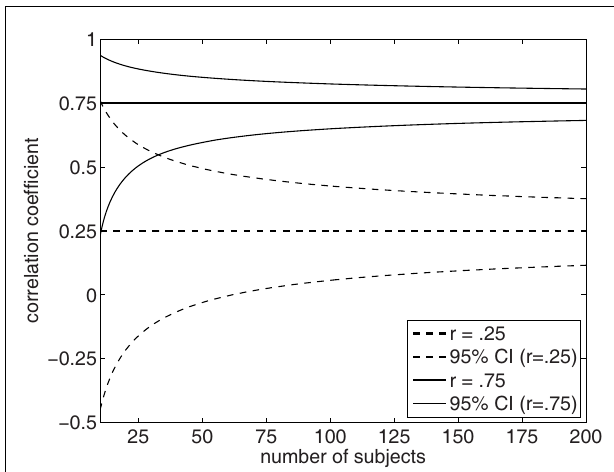
FIGURE 1 |This figure shows the 95% confidence intervals for two Pearson product-moment correlation coefficient values, r = 0.25 and r = 0.75, as a function of sample size. Note the wide confidence intervals when correlations are based on small sample sizes, particularly when n < 50